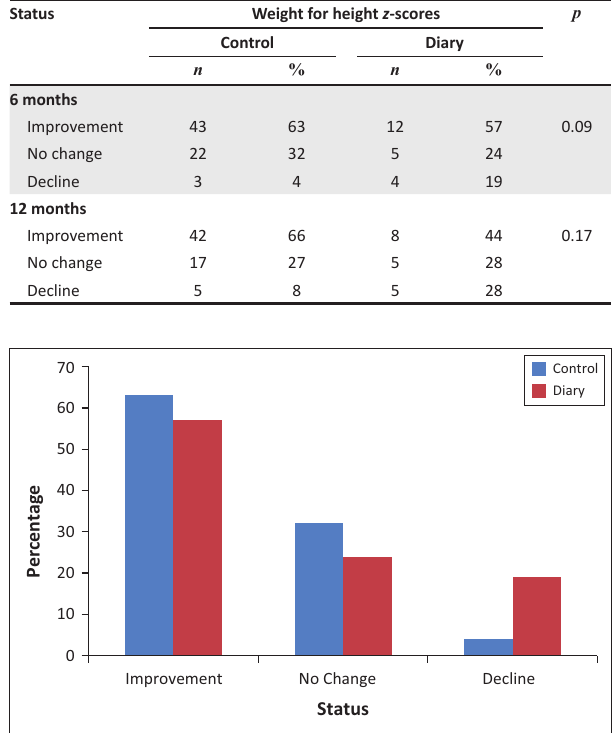
TABLE 4: Weight for height z -score response at 6 and 12 months for both groups.